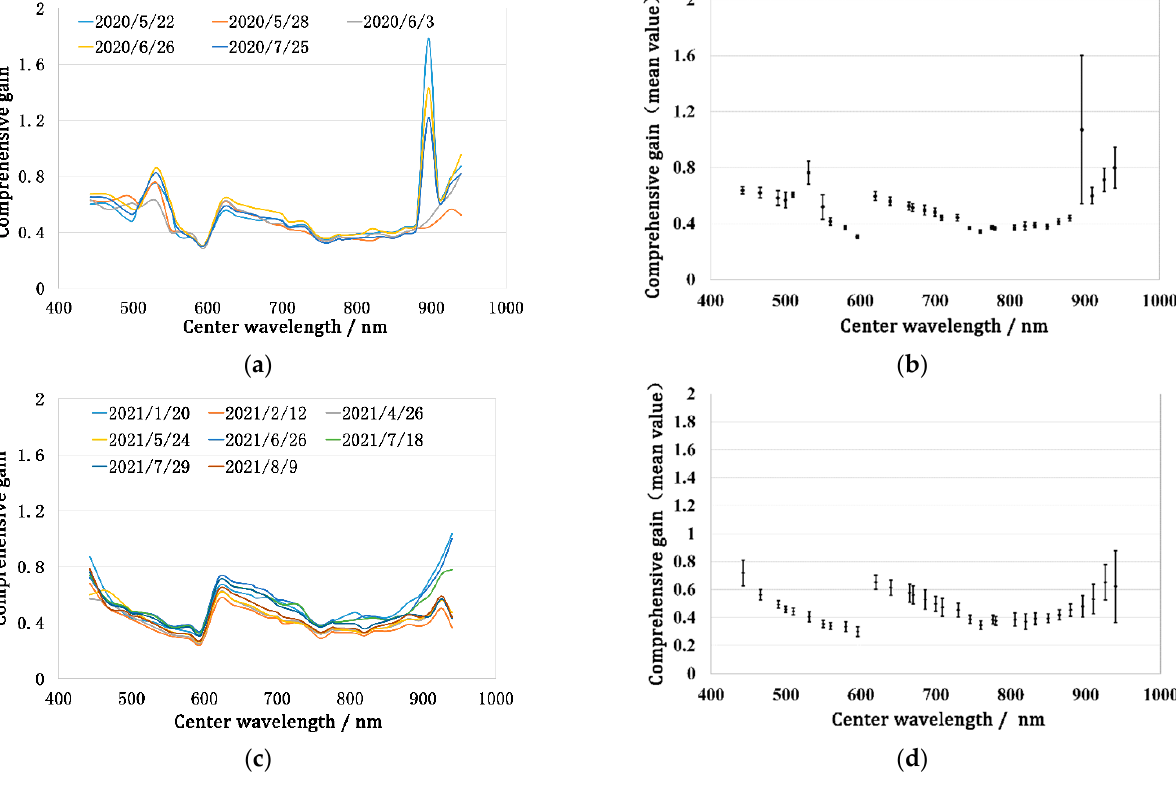
Figure 9. Calibration results of OHS-F CMOS1. ( a ) Description of comprehensive gains in 2020; ( b ) description of averaged value and SD of comprehensive gains in 2020; ( c ) description of comprehensive gains in 2021; ( d ) description of averaged value and SD of comprehensive gains in 2021.